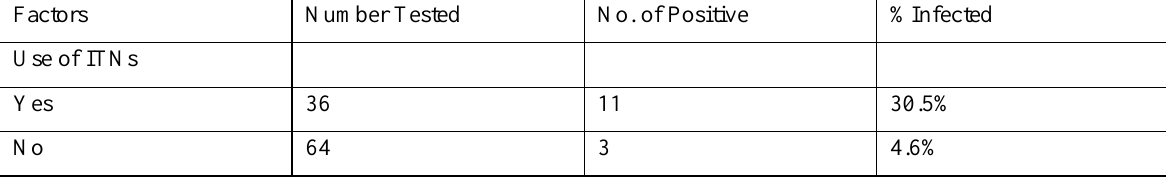
Figure 1. A pie chart showing the incidence rate determined